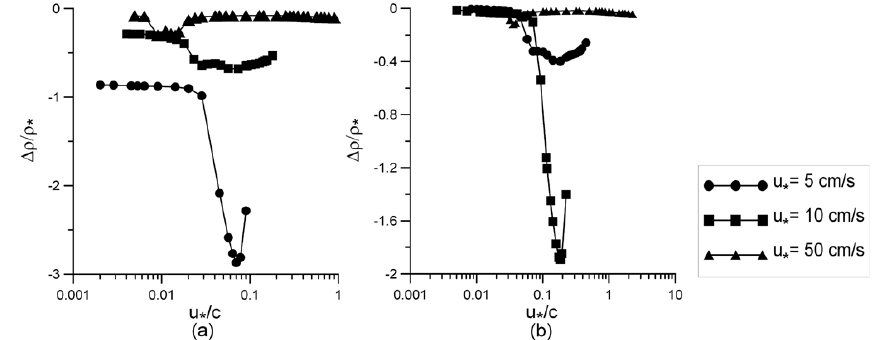
Fig. 7. Dependencies of the normalized nonlinear additives to the density 1ρ/ρ ∗ on wave age in stable (a) and unstable (b) stratification.